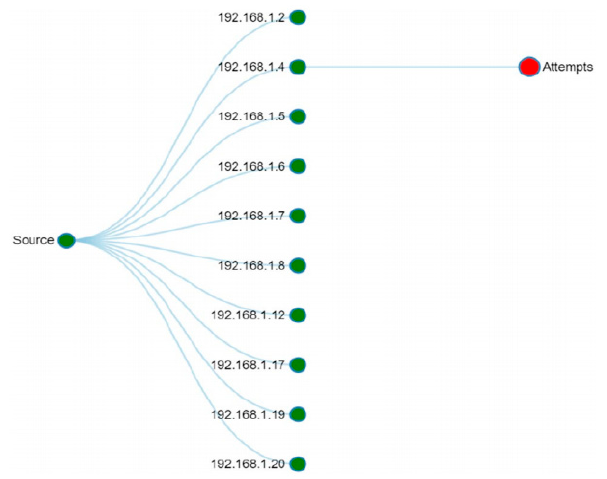
Figure 9. Login failures attempt analysis on a specific system using graphs.